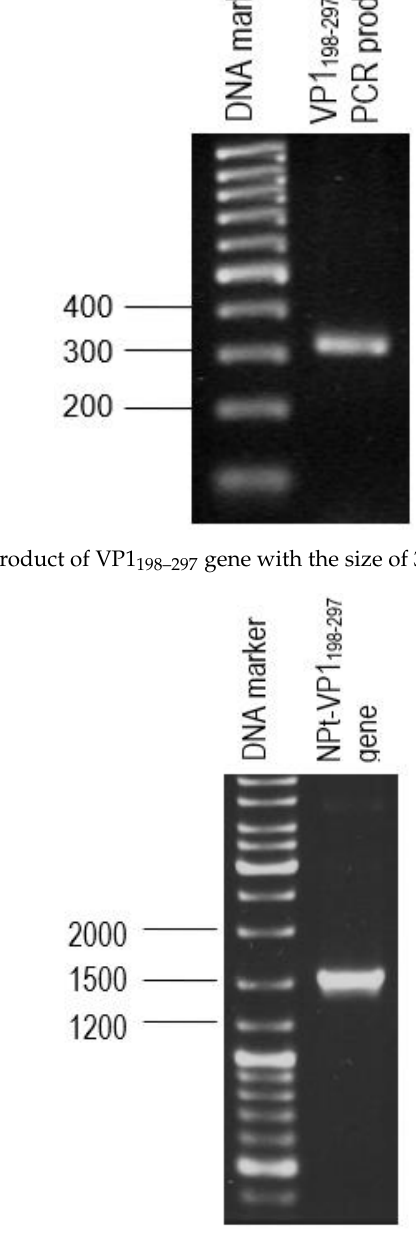
Figure 5. The determination of the inserts of positive clones by PCR. PCR products of the NPt harboring truncated VP1 genes using the forward primer of pTrcHis2 and the reverse primers of respective inserts.